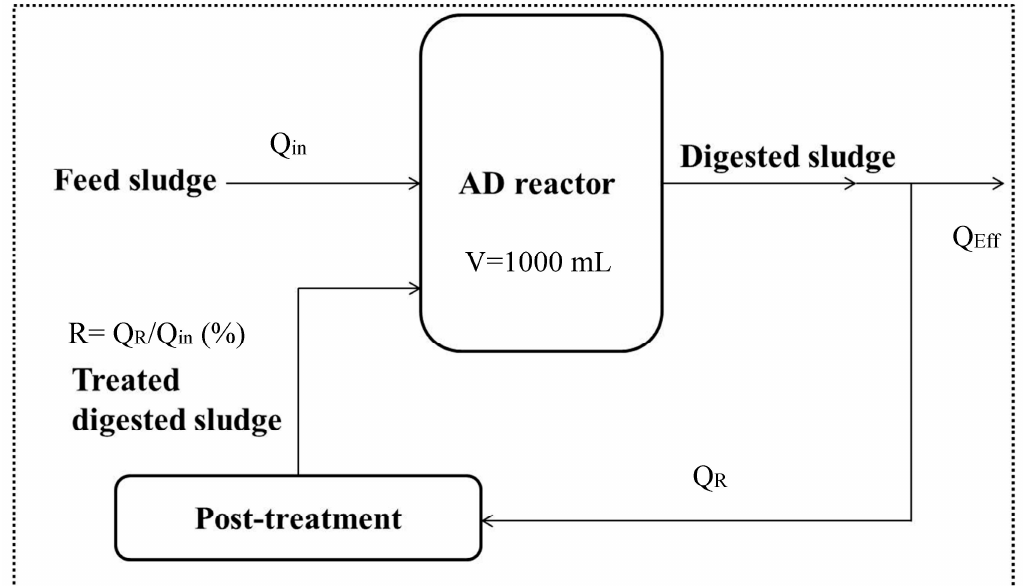
Figure 1. Schematic diagram of the anaerobic digestion process incorporating a post-treatment. Q in = influent flowrate (mL/day), Q eff = effluent flowrate (mL/day), Q R = recycled flowrate (mL/day), and V = working volume (mL).